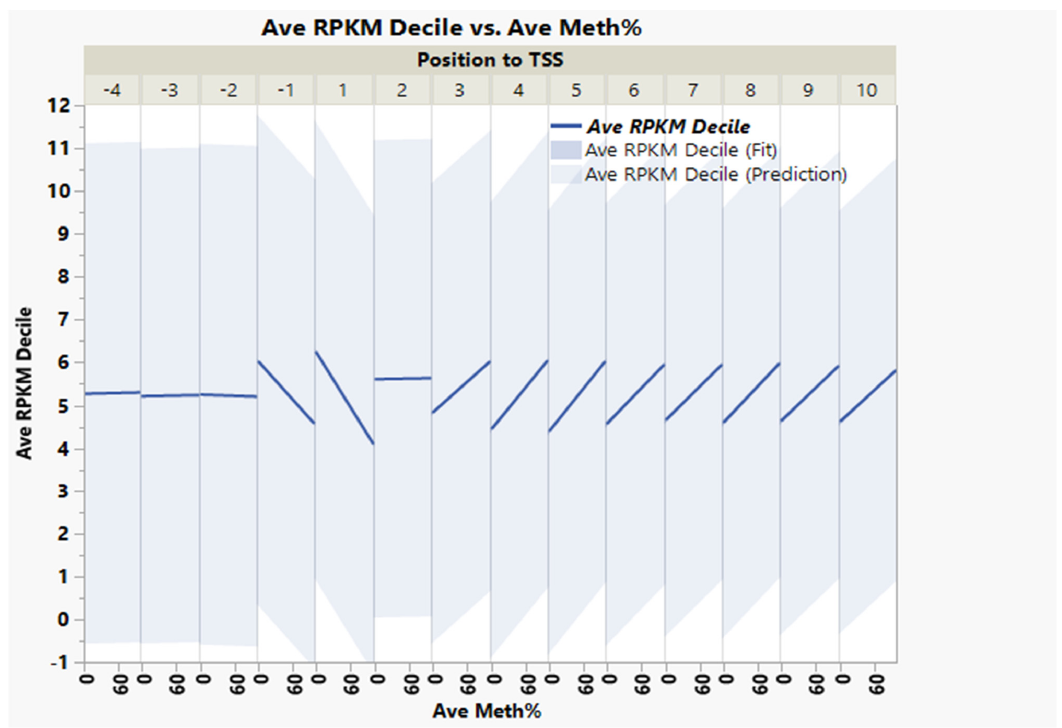
Figure 3. Inverse weak/moderate correlation between gene expression decile and DNA methylation within ±1 kb flanking TSS and positive correlation within the gene body’s +3 to +10 kb region.